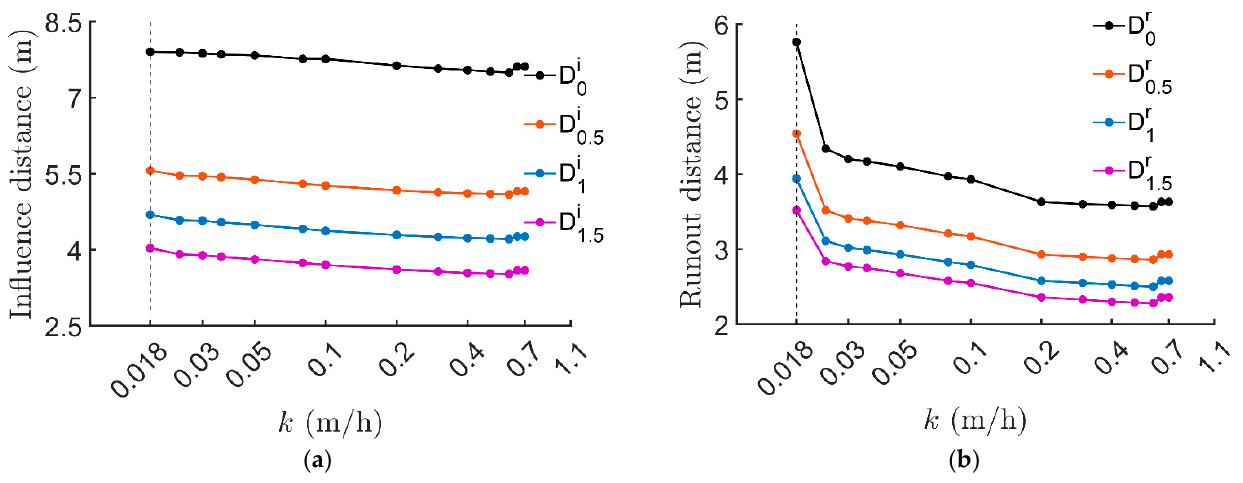
Figure 15. Variations in influence distances and runout with different hydraulic conductivity val- ues: ( a ) different influence distances in uniform slopes; ( b ) different runout distances in uniform slopes.